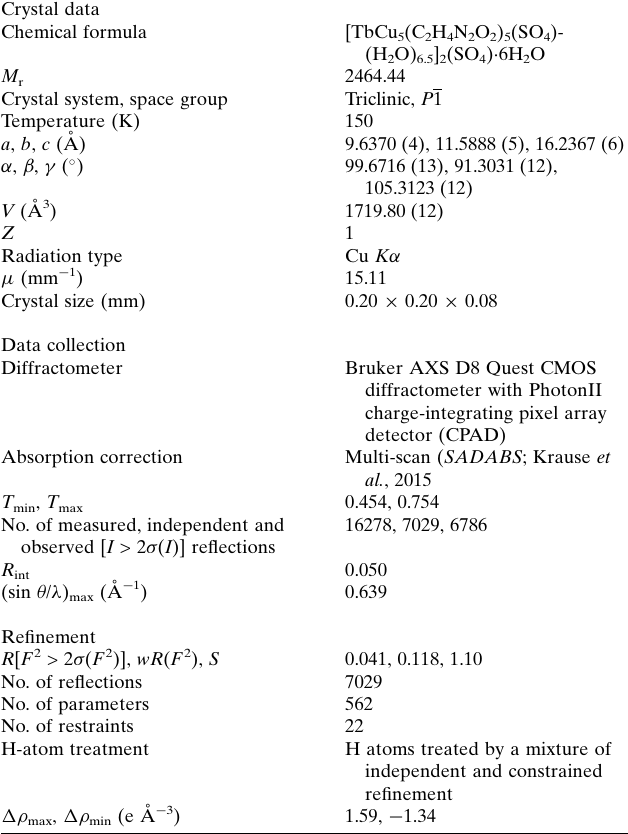
Table 5 Experimental details. Crystal data Chemical